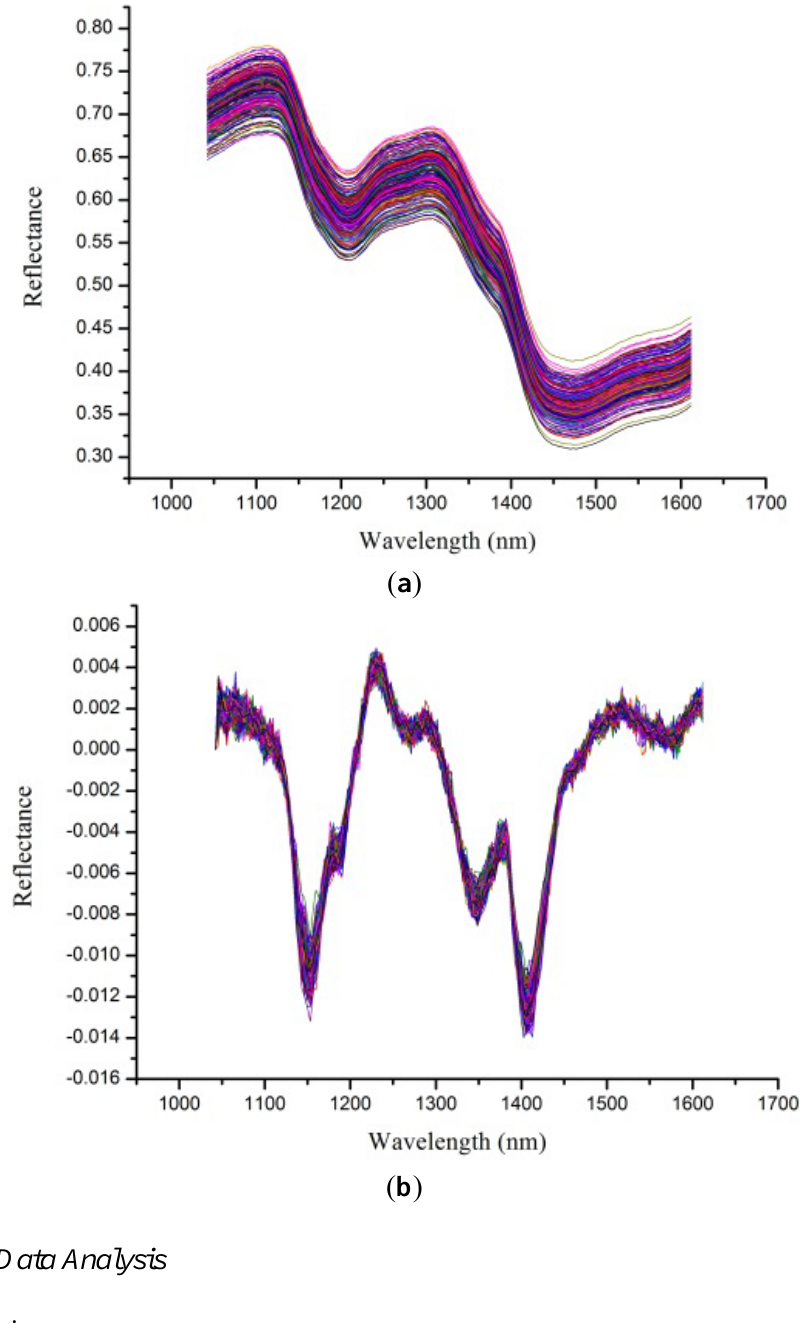
Figure 2. ( a ) Raw spectra of rice seeds. ( b ) first derivative preprocessed spectra of rice